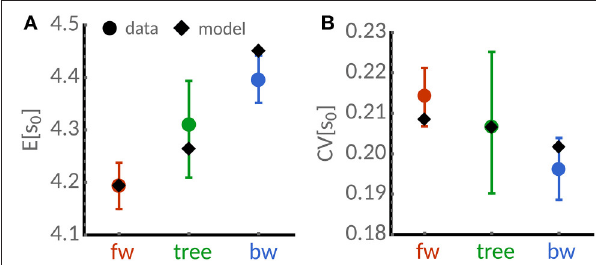
FIGURE 3 | Cell-size statistics of the mycobacterium S. smegmatis . Analysis of the time-lapse microscopy data for cells grown in glycerol reported in [9]. (A) Mean cell length estimated using lineage-weighted statistics of backward lineages (blue) and tree statistics (green) is lower than in the forward lineage (red dots). (B) The corresponding coefficient of variation of cell size of backward lineages (blue) and tree statistics (green) is lower than in the forward lineage (red dots). Error bars denote 95 % -confidence intervals obtained from bootstrapping using the sample weights (1). Diamonds denote model predictions for a adder sizer control ( a = 1) using Equations (21a), (21b), and (23). Best-fit parameters obtained from non-linear least-squares are E [ η ] = 4.19, CV p = 0.17, CV η = 0.10, skew[ η ] =